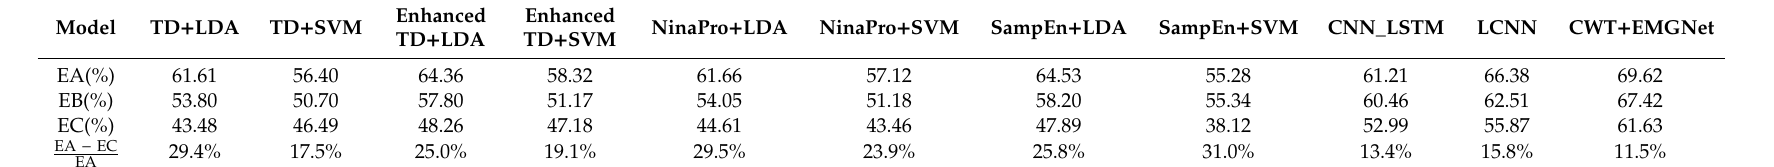
Table 4. Classification accuracy on the DB5 Dataset. (We use the same samples to test these